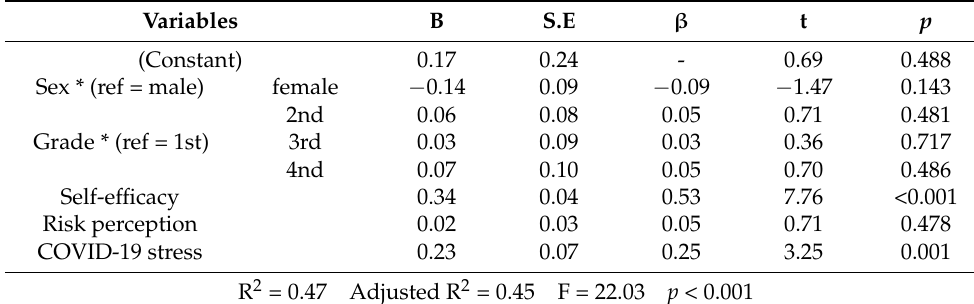
Table 5. Influencing factors on COVID-19 preventive behavior. Variables B